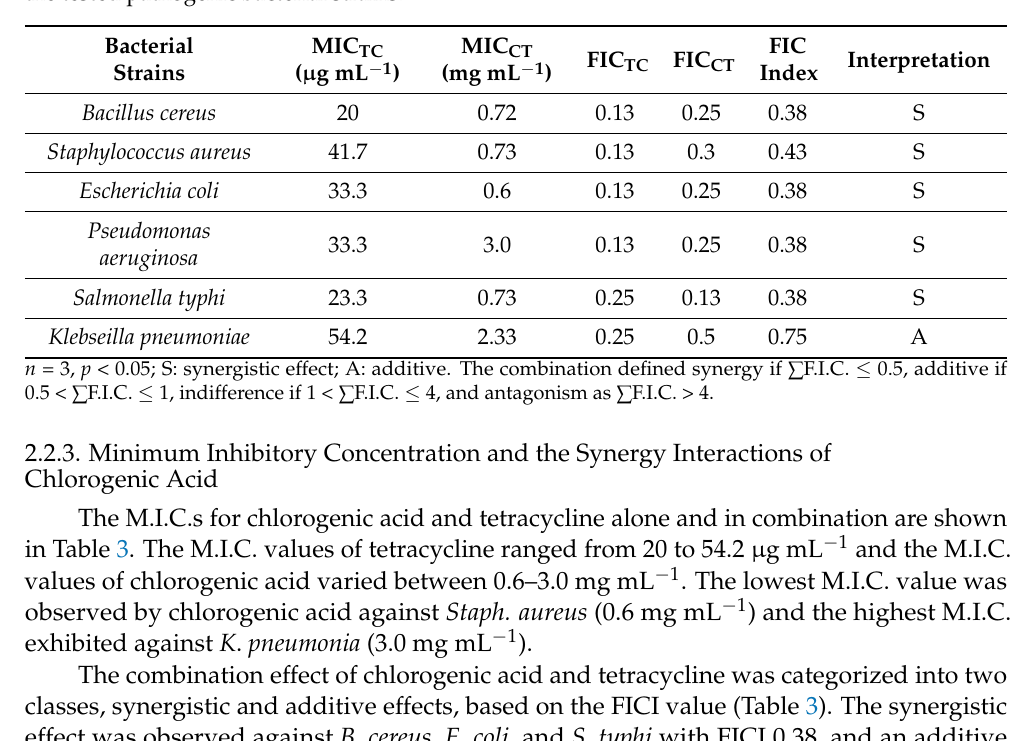
Table 2. M.I.C.s and F.I.C. indices of tetracycline (T.C.) in combination with catechin (C.T.) against the tested pathogenic bacterial strains.